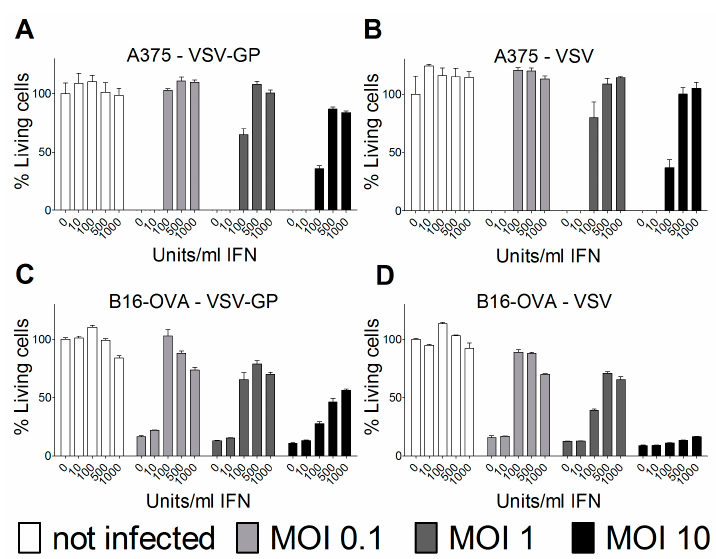
Figure 6. Type I interferon (IFN) limited VSV-GP replication in melanoma cell lines. Human A375 ( A , B ) or murine B16-OVA melanoma cells ( C , D ) were pre-incubated with indicated amounts of IFN